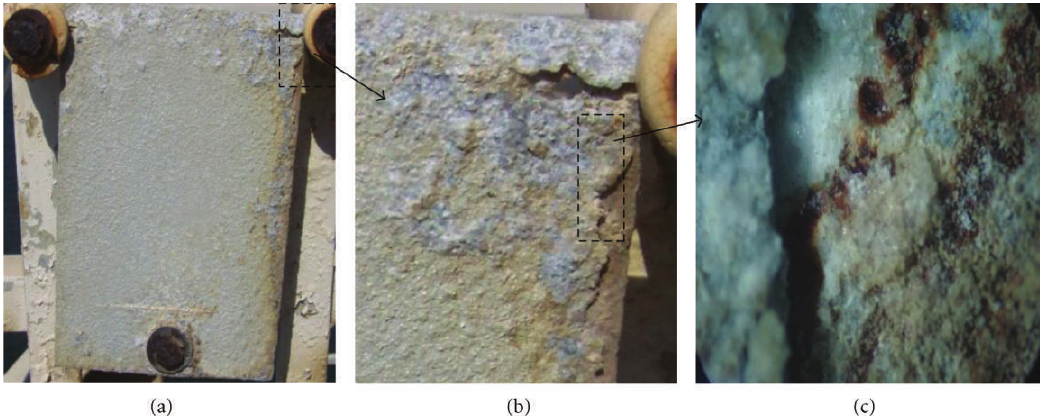
Figure 6: Thermal-sprayed coating of Zn/Al by flame process (318 μ m). (a) 71 months of exposure. (b) Delamination detail of the coating in the right edge. Notice the formation of corrosion products of Zn (white color) and the substrate corrosion (brown color). (c) A magnifying stereoscopic view